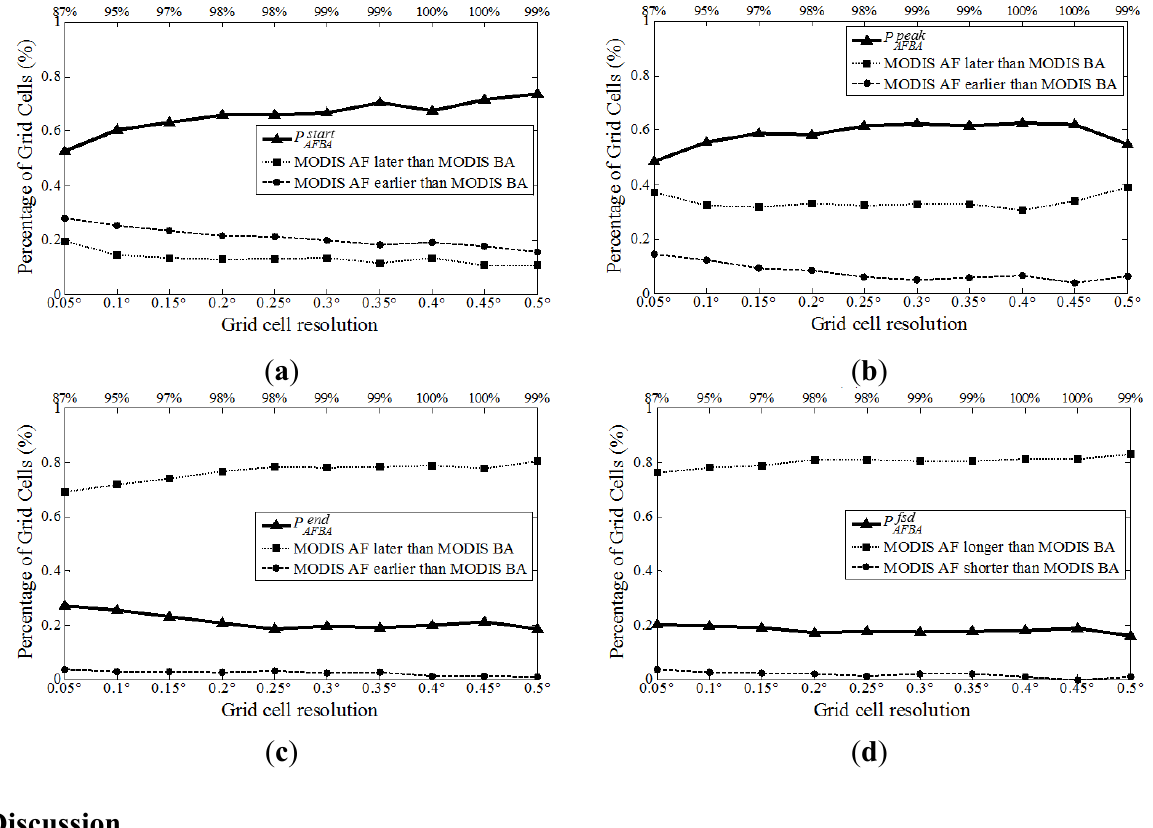
Figure 13. Comparisons of the ( a ) start; ( b ) peak; ( c ) end; and ( d ) duration of the fire season in the Central African Republic (CAR) derived from the MODIS active fire (AF) and burned area (BA) datasets at 16-day temporal resolution. For only the grid cells where both datasets recorded a fire pixel, the value of P (triangular symbols) indicates the proportion of grid cells that were assigned an identical start, peak, end or duration by both fire products. Where the fire products disagree, fire seasonality is characterized based on whether the MODIS active fire product detected an earlier/later or a longer/shorter fire season than the MODIS burned area product. The proportion of grid cells in the CAR where comparisons were possible are labelled along the top